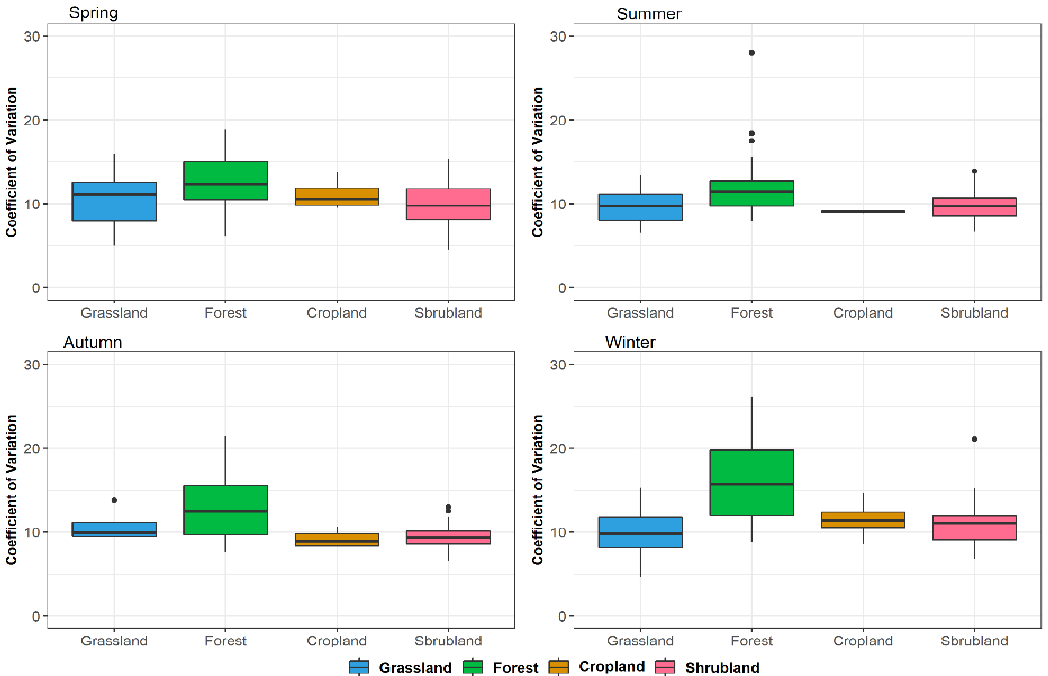
Figure 4. Coefficients of variation of the seasonal NDVI3g during 1981–2015 for different vegeta- tion types for Amathole District